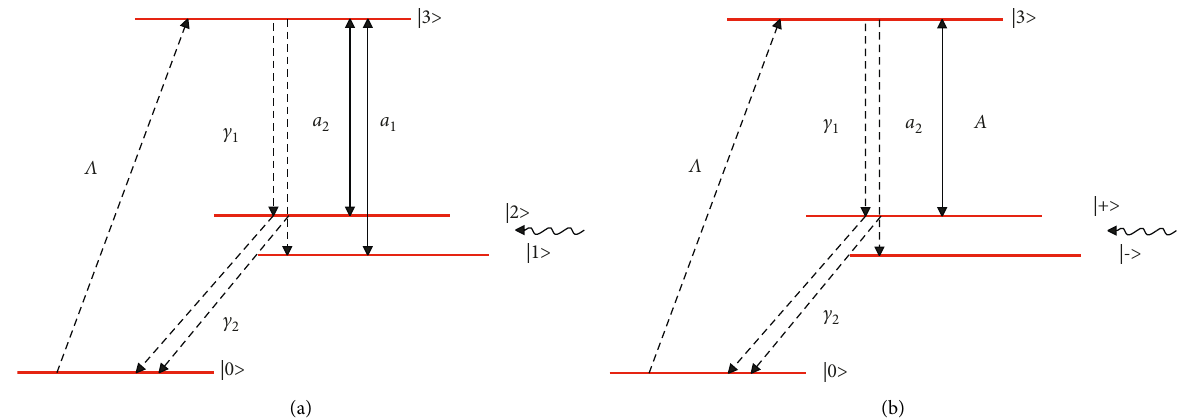
Figure 1: (a) Schematic diagram of the audio and field effects of incoherently pumped quantum beat audio and (b) equivalent audio field interaction diagram in the decorated state of the microwave field.